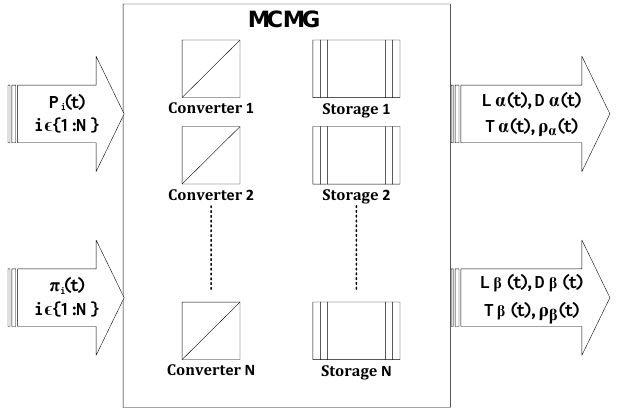
Figure 5. Simplified figure of analyzed MCMG (represented as energy hub).